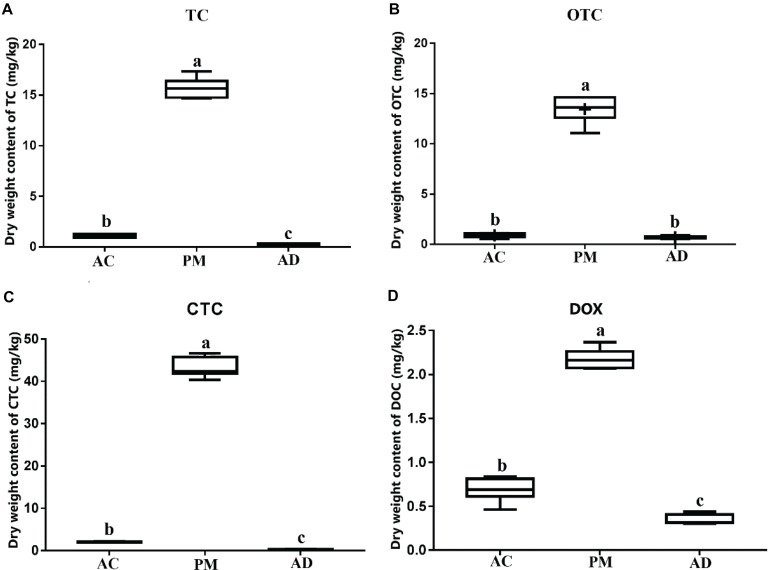
(A) Dry wight content of tetracycline (TC). (B) Dry wight content of oxytetracycline (OTC). (C) Dry wight content of chlortetracycline (CTC). (D) Dry wight content of doxycycline (DOX). Dynamics of TCs antibiotics (OTC, TC, CTC, and DOX). PM, swine manure samples; AC, aerobic composting samples; AD, anaerobic digestion samples. The error bar indicates standard error.